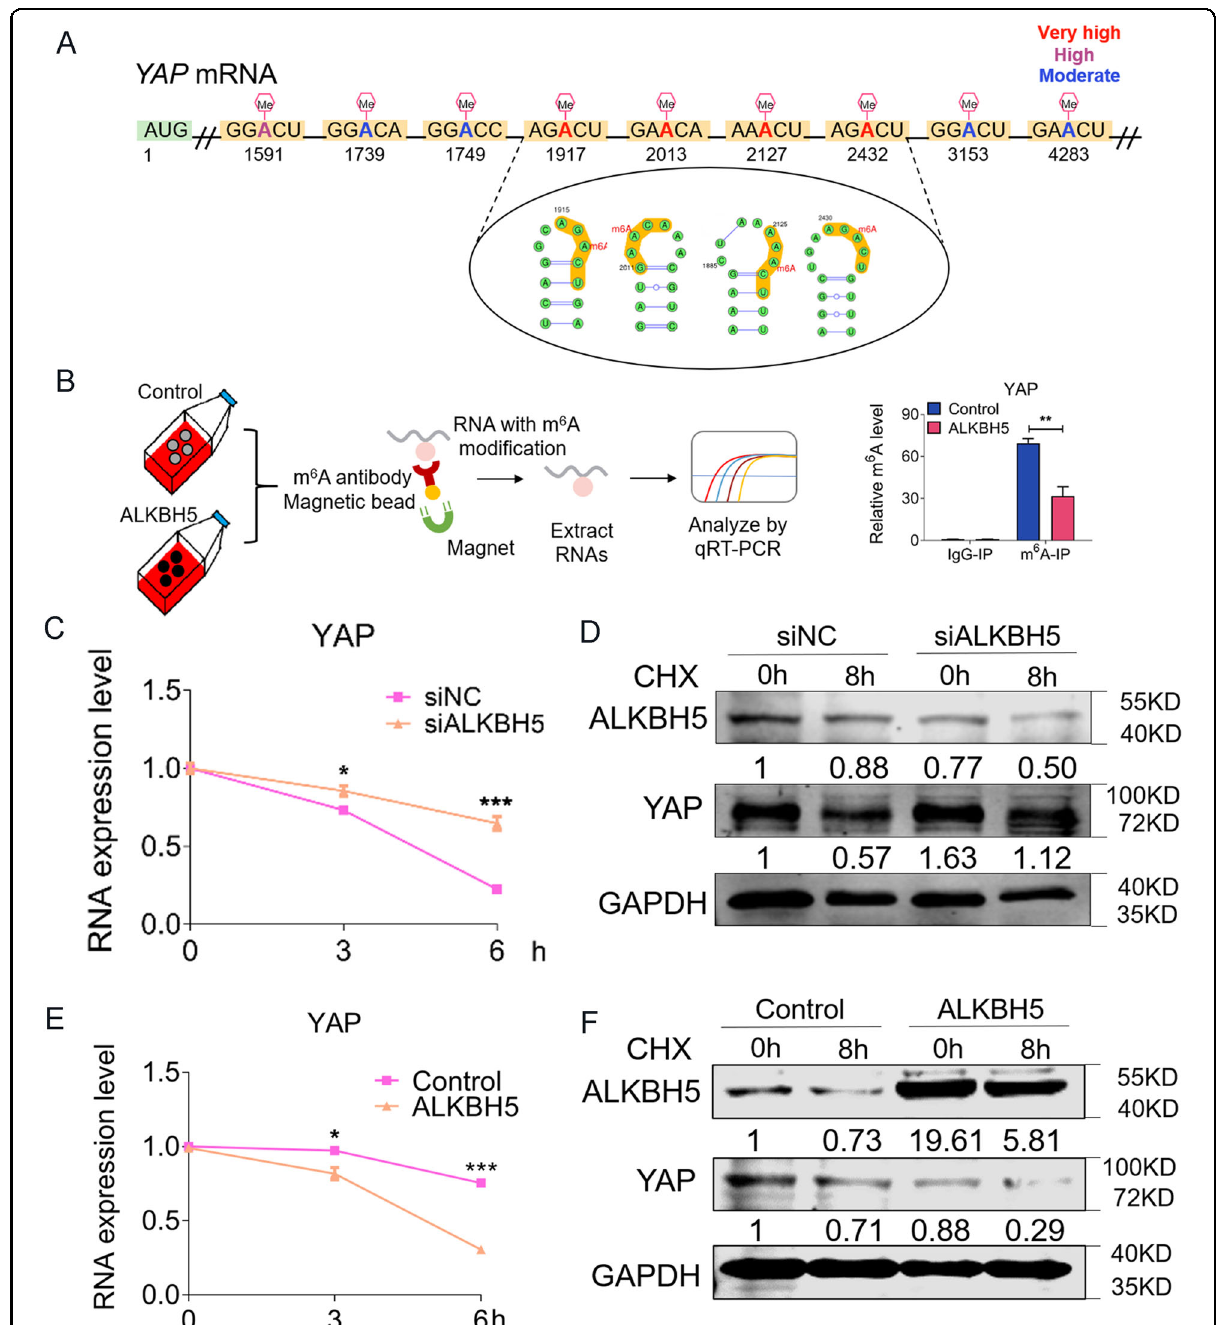
Fig. 7 ALKBH5 directly regulates mRNA and protein stability of YAP. A Nine potentially m 6 A sites of YAP mRNA predicted by SRAMP program. B schematic diagram illustrating the procedure of gene-speci fi c m 6 A-qPCR on left. Change of m 6 A modi fi cation in speci fi c regions of YAP transcripts with ALKBH5 overexpression in U2OS cells on right ( n = 4). C qRT-PCR showing YAP transcripts stability in ActD-treated cells after transfected with ALKBH5 siRNA. ( n = 3). D YAP-protein stability after ALKBH5 silencing. Cells were harvested at 0 and 8 h after CHX treatments. E qRT-PCR showing YAP transcripts stability in ActD-treated cells after transfected with ALKBH5 plasmids. ( n = 3). F YAP-protein stability after ALKBH5 overexpression. Cells were harvested at 0 and 8 h after CHX treatments. Data are expressed as mean ± SEM. * P < 0.05; ** P < 0.01; *** P < 0.001.